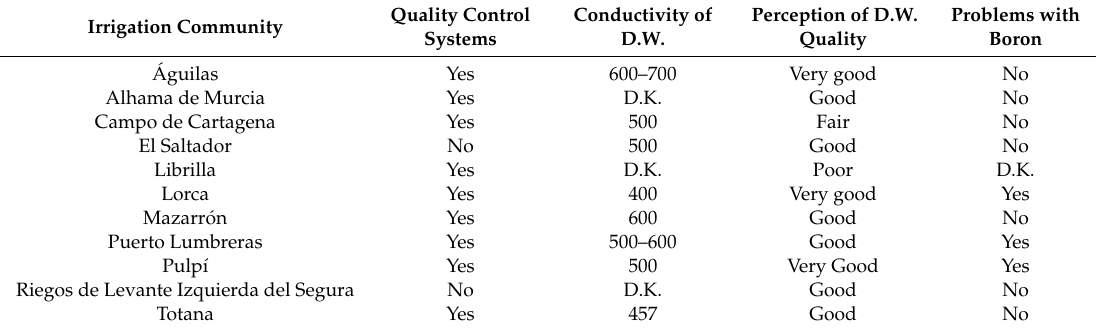
Table 4. Main issues related to desalinated water quality by irrigation community. Irrigation